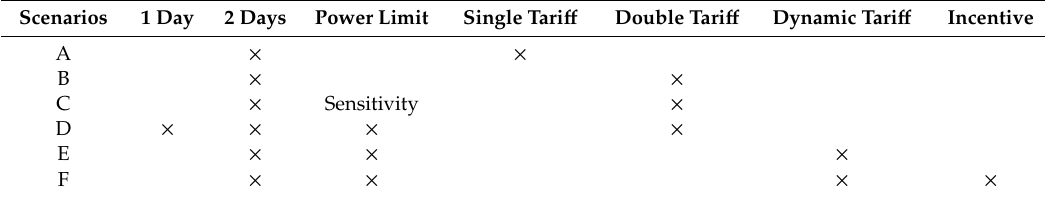
Table 4. Characteristics of di ff erent